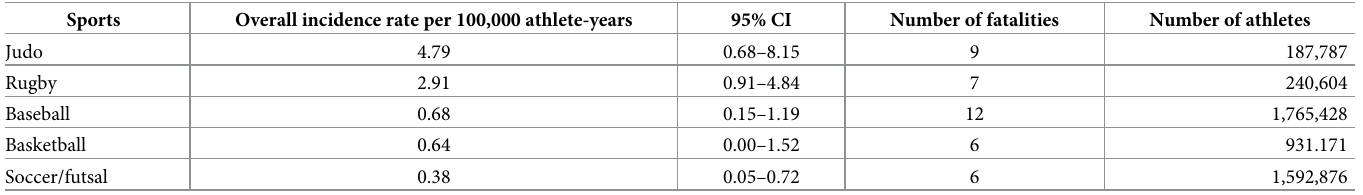
Table 1. Overall incidence rate of sports-related fatalities in male athletes reported to Japan Sports Council that occurred during high school organized sports between 2009 and 2018 in Japan. Sports